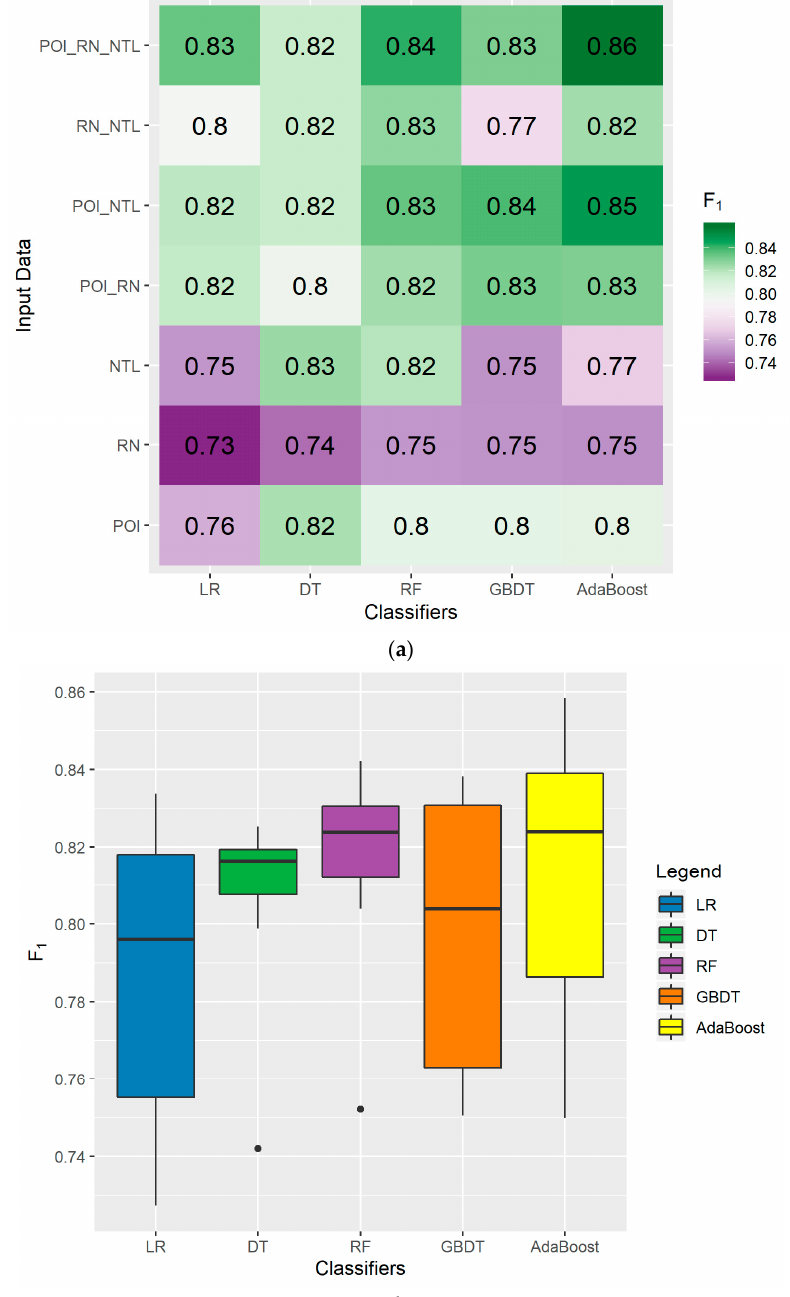
Figure 9. The ( a ) heat map and ( b ) boxplot of F 1 values for 35 combinations between the five classifiers and seven types of input data using the BAIC.